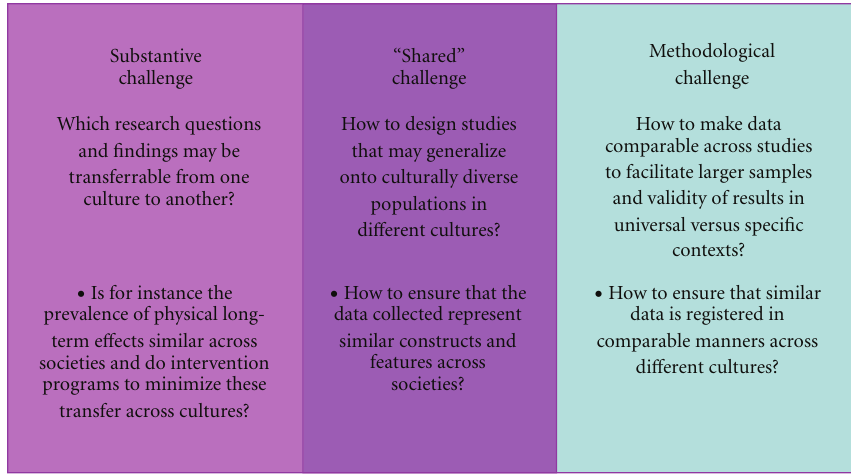
Figure 2: An illustration of possible groupings of cross-cultural